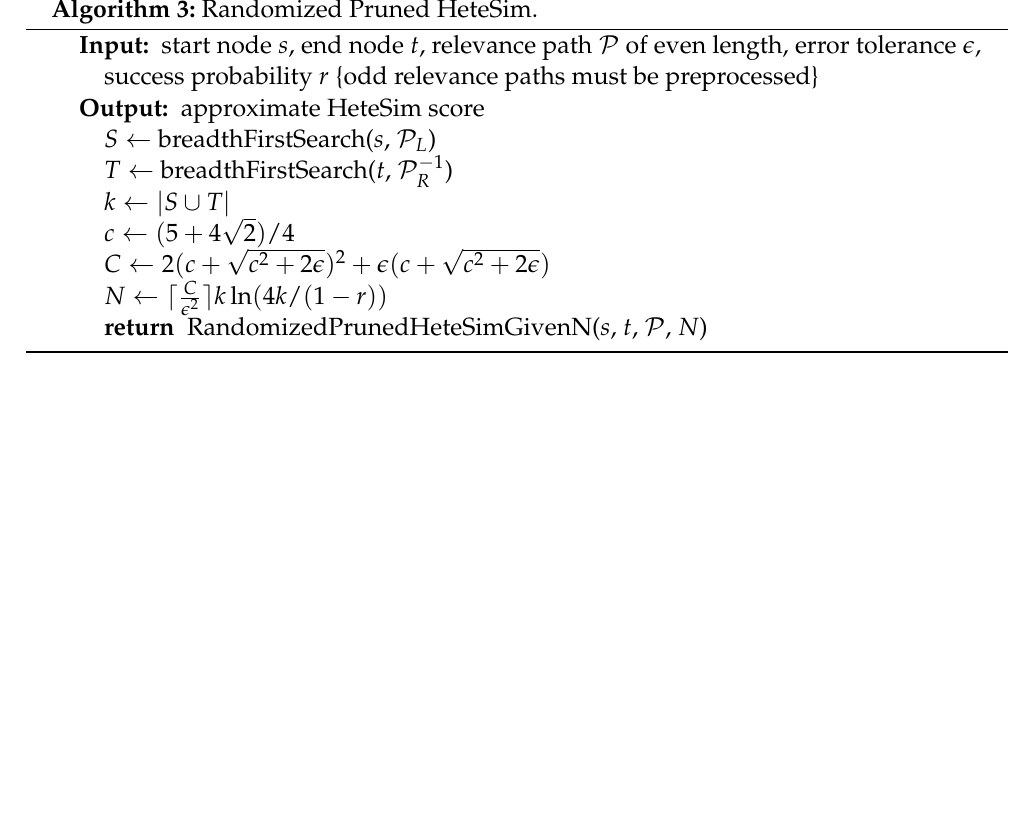
Algorithm 3: Randomized Pruned